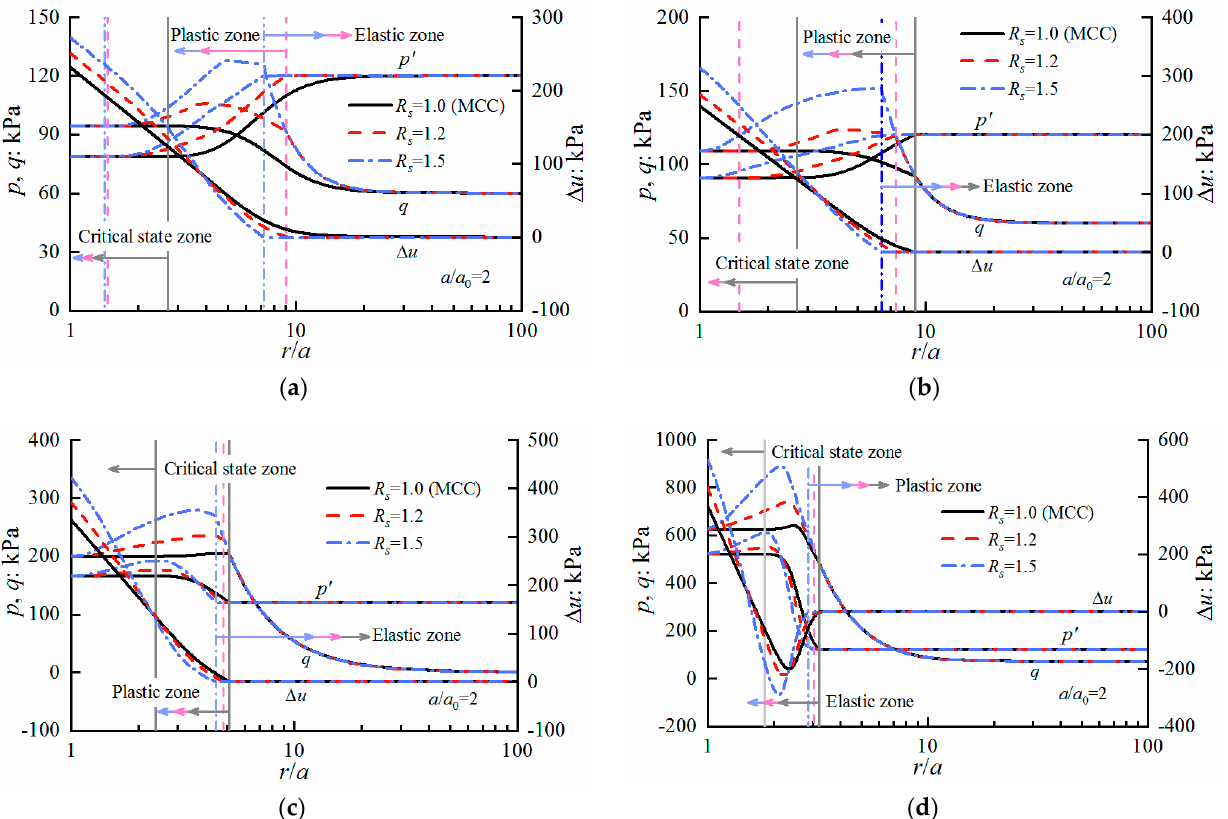
Figure 12. Influences of initial structure and destructuration on the distributions of p ′ , q and Δ u around the cavity: ( a ) R = 1; ( b ) R = 1.2; ( c ) R = 3; ( d ) R = 10.